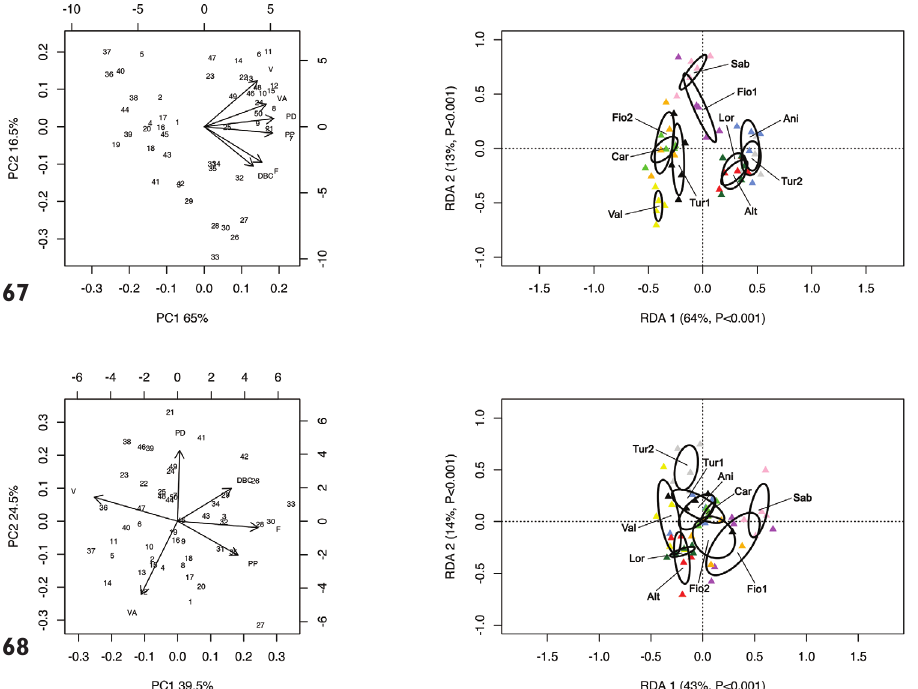
Figures 67, 68. Principal component analysis (PCA) and Redundancy analysis (RDA) with population constraint applied to the original genital matrix ( 67 ) and shape-related Z-matrix ( 68 ) of specimens of Monacha pantanellii